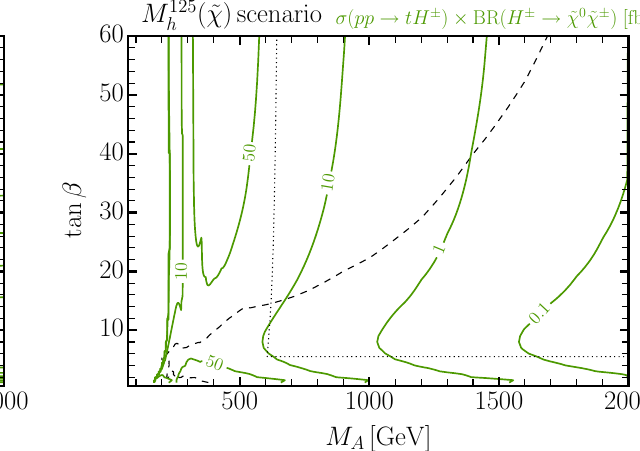
M 125 (˜ χ ) scenario σ ( pp → tH ± ) × BR( H ± → ˜ χ 0 ˜ χ ± ) [fb] h